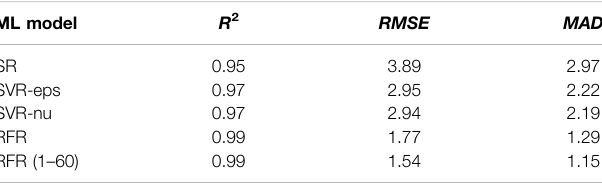
TABLE 4 | System ef fi ciency comparisons of different machine learning (ML)